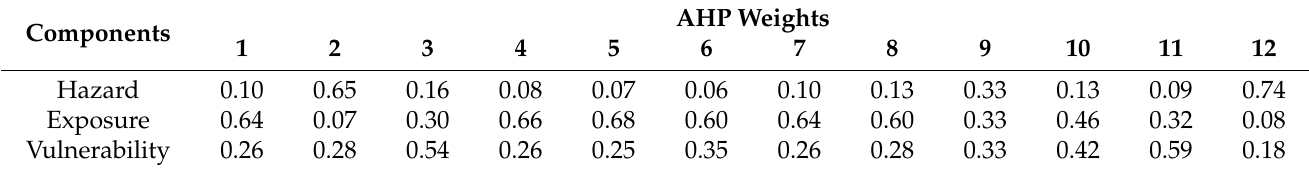
Table A2. Relative weight values [33].